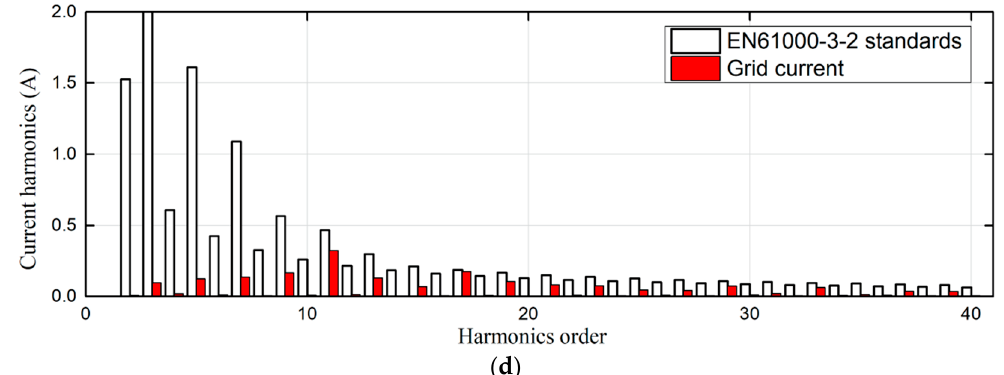
Figure 16. Experimental results of the conventional SMO estimate method with a PI controller: ( a ) Motor Speed; ( b ) Position and estimated error; ( c ) DC-link voltage and grid current; ( d ) FFT analysis of grid current.